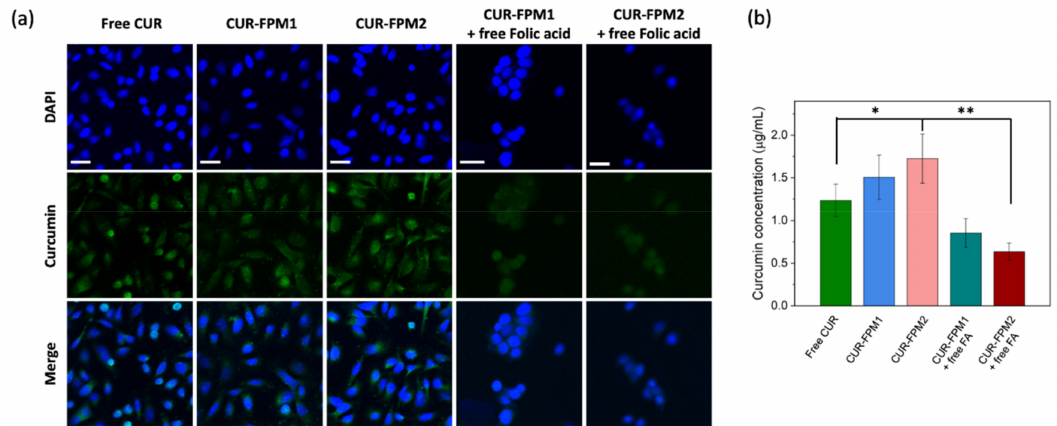
Figure 5. ( a ) CLSM images of HeLa cells treated with free CUR, CUR-FPM1, and CUR-FPM2 micelles with or without the addition of 1 mM of free folic acid for 2 h. Scale bar: 30 µ m; ( b ) quantitation of curcumin in HeLa cells treated with free CUR, CUR-FPM1, and CUR-FPM2 micelles with or without the addition of 1 mM of free folic acid for 2 h. Data are presented as the mean ± standard deviation. p values: * p < 0.05, ** p < 0.01, significance level.